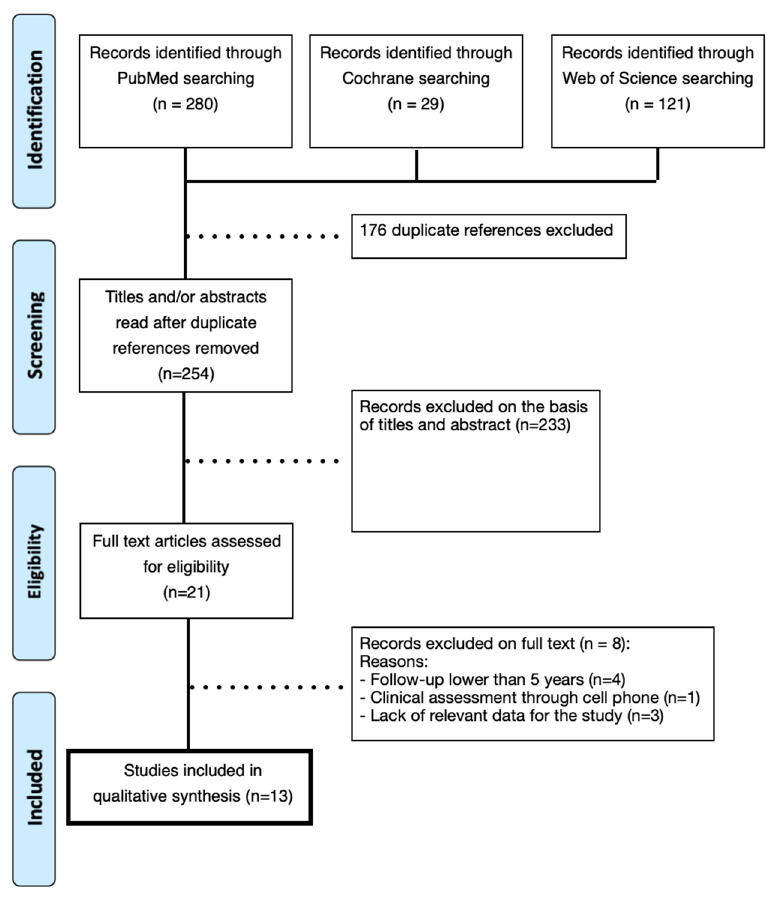
Figure 1. Article selection strategy, according to the PRISMA Flowchart (Preferred Reporting Items for Systematic Reviews and Meta-Analyses). Table 1. Data extraction table and descriptive analysis of the included articles.